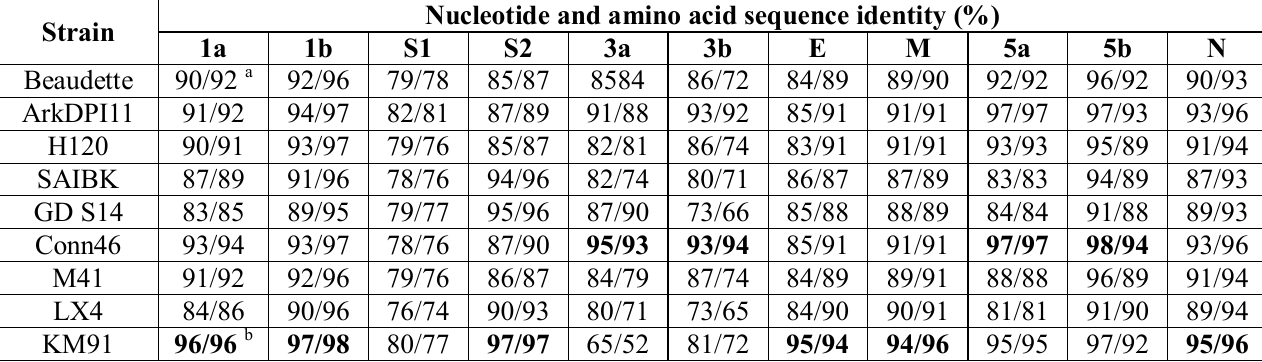
Table 2. Pair-wise comparison of nucleotide and amino acid sequences of the SNU8067 genes with other infectious bronchitis virus (IBV)